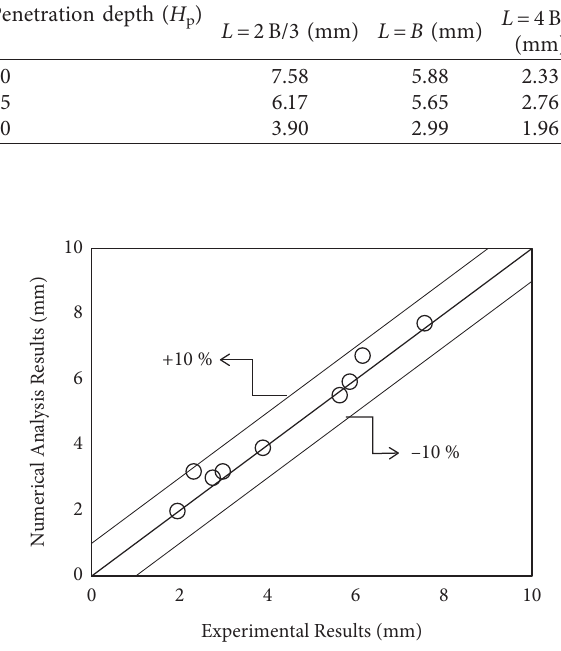
Figure 19: Comparison of data from numerical analyses and laboratory experiments.